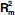
Heat maps of Rm2 (fixed-effects goodness of fit) for the best-fit models for each structure-function relationship.Each row is a different functional biomarker, and each column is a different structural biomarker. The first five rows are global measures from the entire HOV, and the last four are local measures from functional data along the b-scan line. For each functional biomarker, the median Rc2 (mixed-effects fit) across all structural biomarkers is shown. Superscripts H or V indicate the b-scan direction, and * indicates statistical significance.